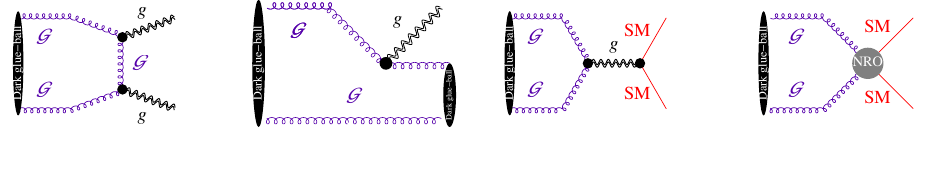
Figure 1 . Possible gravitational decays of dark glueballs. SM denotes any Standard Model particle, including